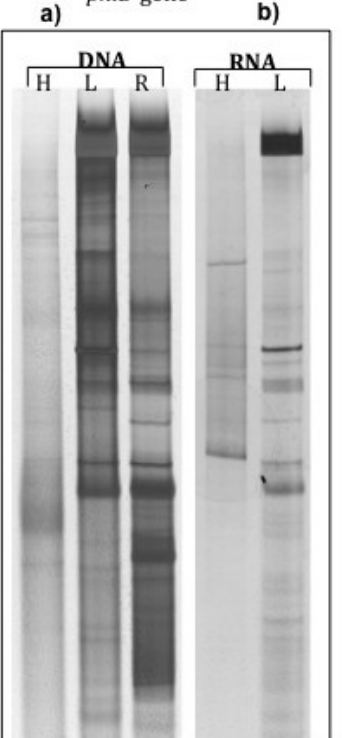
Figure 1. DGGE patterns of phlD gene fragments amplified from ( a ) heavy, light, and root DNA fractions and ( b ) 12 C- & 13 C-RNA fractions retrieved from the rhizosphere of A. thaliana after 27 days of 13 CO 2